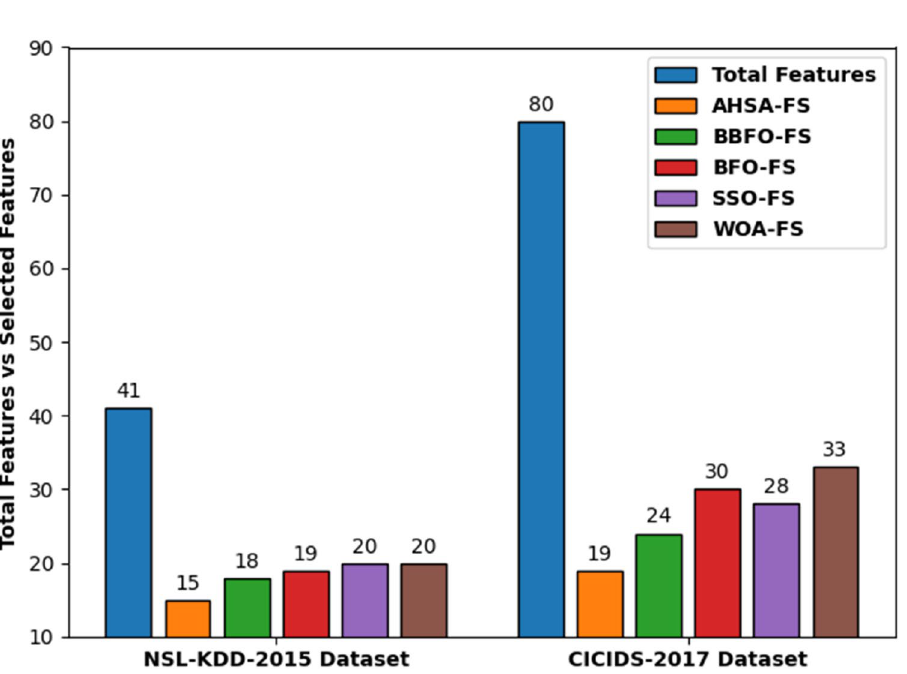
Figure 5. Comparative total features vs selected features of the AHSA-FS